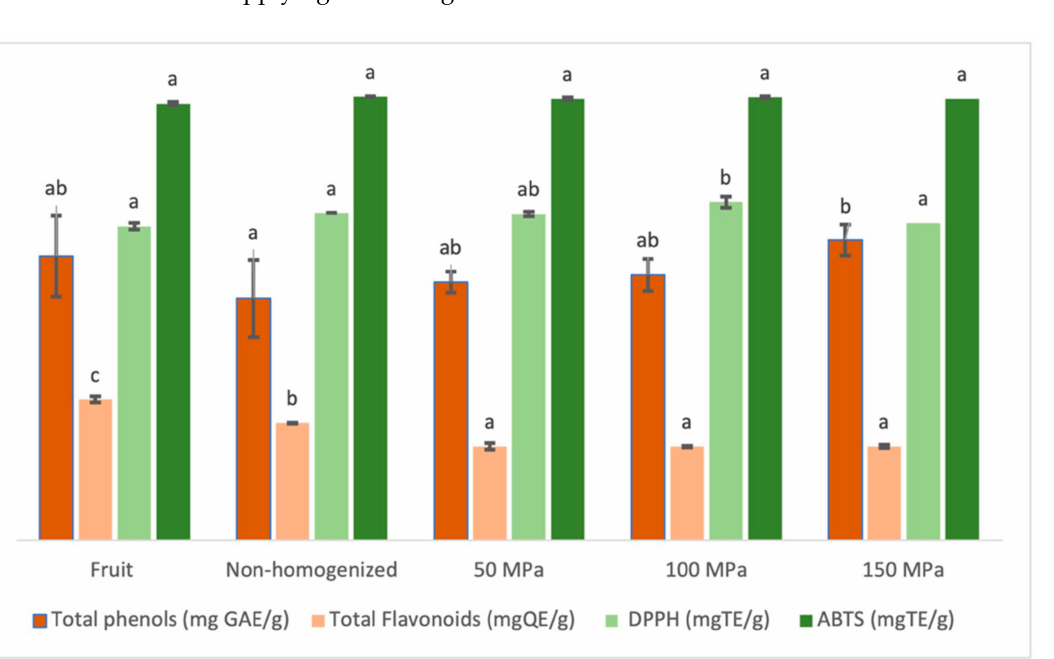
Figure 3. Total phenolic content, total flavonoids content, and antioxidant capacity of lulo fruit and nonhomogenized and homogenized lulo juices by the DPPH (2.2-diphenyl-1-picrylhydrazyl) and ABTS + (2.2 (cid:48) -azino-bis-3-ethylbenzothiazoline-6- sulfonic acid) methods. Different letters for the same determination indicate significant differences ( p ≤